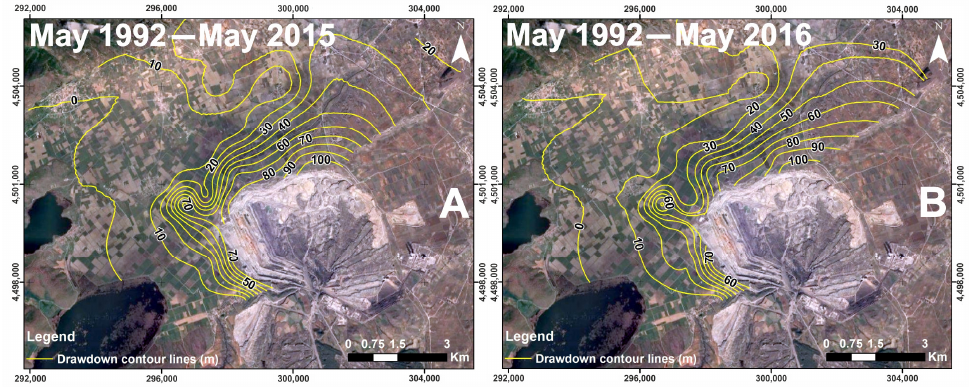
Figure 3. Equal drawdown contour lines between: ( A ) May 1992–May 2015 and ( B ) May 1992–May 2016.